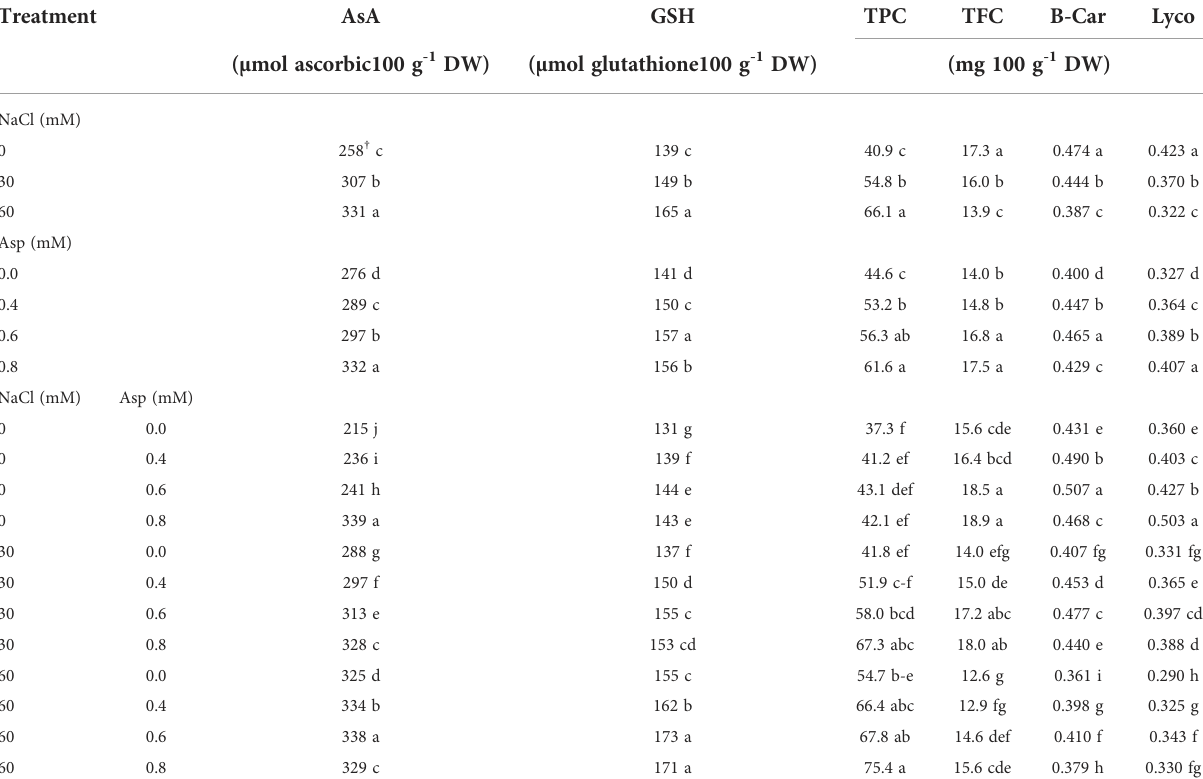
TABLE 5 Effect of aspartic acid (Asp) on non-enzymatic antioxidants (ascorbate; AsA, glutathione (GSH), total phenolic content (TPC), total fl avonoid content; TFC, beta carotene; B-Car, lycopene; Lyco) in wheat plants grown under salt stress (NaCl) for 60 days.